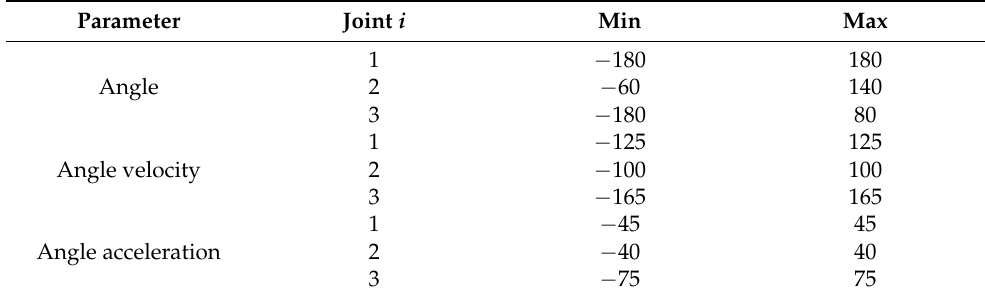
Table 3. RS010N robot joint